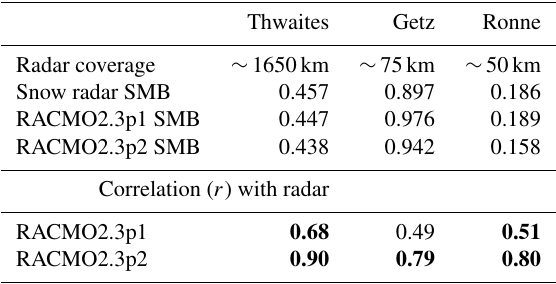
Table 3. Comparison of RACMO2.3p2 and RACMO2.3p1 SMB (mmw.e.y − 1 ) with radar-derived snow accumulation (Medley et al., 2013) for three regions in West Antarctica: Thwaites glacier (mean latitude/longitude: 77.80 ◦ S, 104.66 ◦ W) and Getz (74.51 ◦ S, 125.54 ◦ W) and Ronne (80.39 ◦ S, 72.21 ◦ W) ice shelves. Signifi- cant ( > 95%) correlations are denoted in